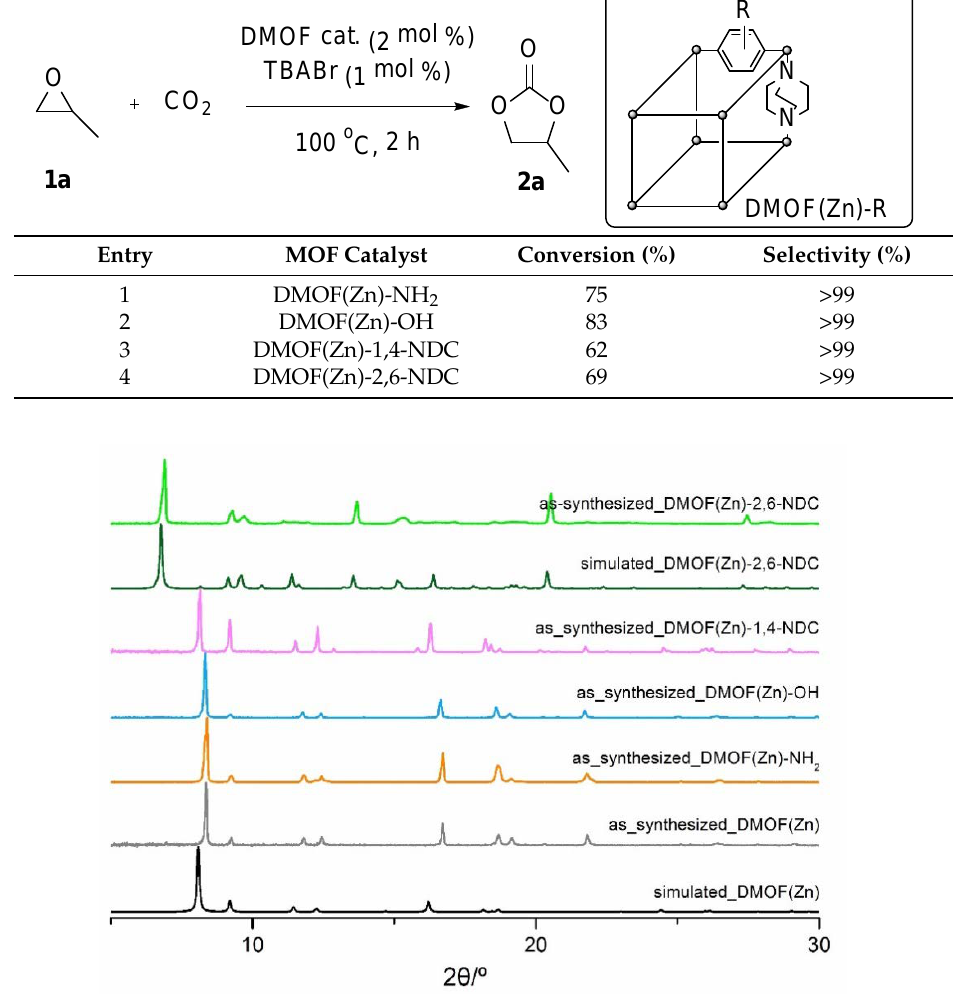
Figure 3. Powder X-ray diffraction (PXRD) patterns of DMOFs with different functionalities on the